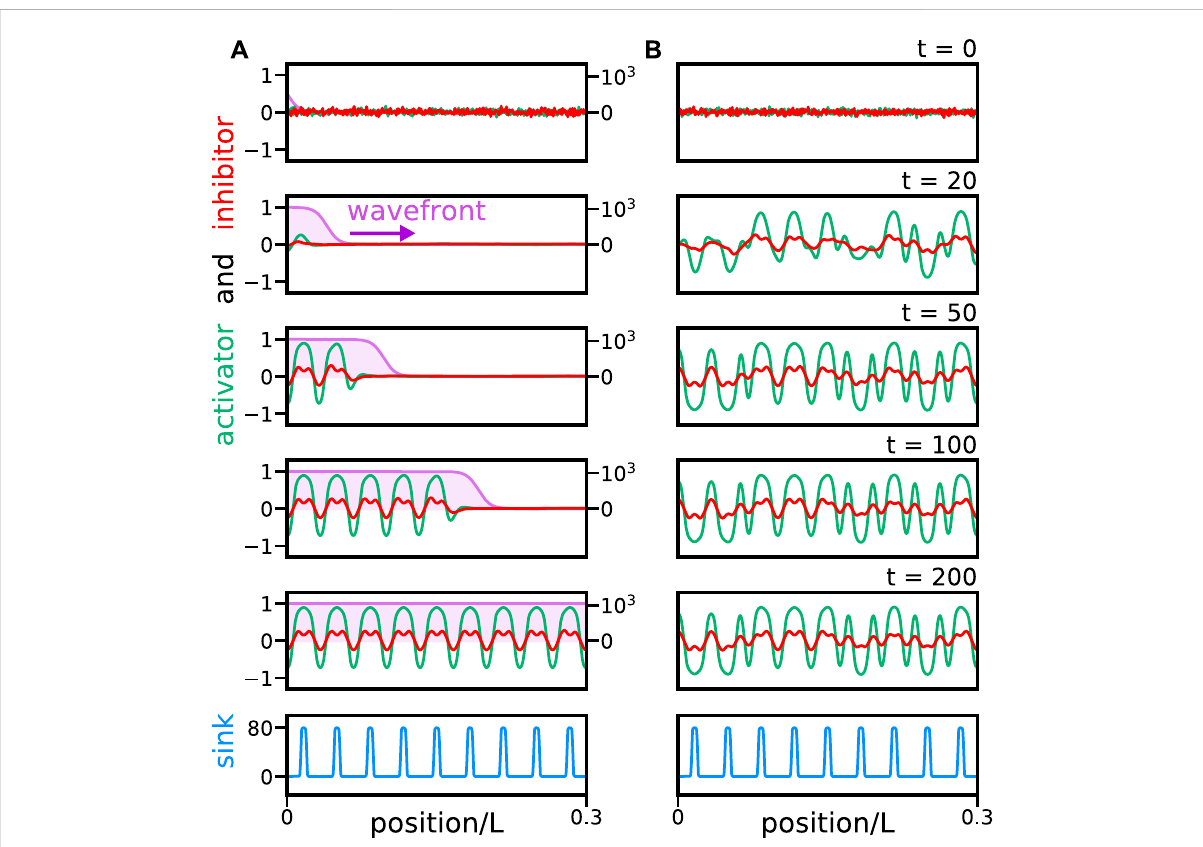
FIGURE 2 Reaction wavefront theory can produce a sequential pattern without defects in the presence of noise. Snapshots of solutions (A) of reaction wavefront theory Eqs 15, 16, and (B) Eqs 13, 14 lacking a reaction wavefront. Activator (green line) and inhibitor (red line) dimensionless activities (left axisscale)togetherwithreactionwavefront γ ( x , t )(purplelineandshade,rightaxisscale)atdifferenttimes.Thebottompanelshowstheinhibitorsink pro fi le(lightblueline).Positionisscaledbythedimensionlesssystemsize, L =30 λ =17.1,whichischosentoaccommodate30segments,similar to the 31 segments in zebra fi sh [17, 24]. Time is expressed in frames and 1 frame ≈ 0 . 0004 time units. Random initial conditions have mean μ = 0.01 and standard deviation σ 0 = 0.05. Other parameters are as in Table